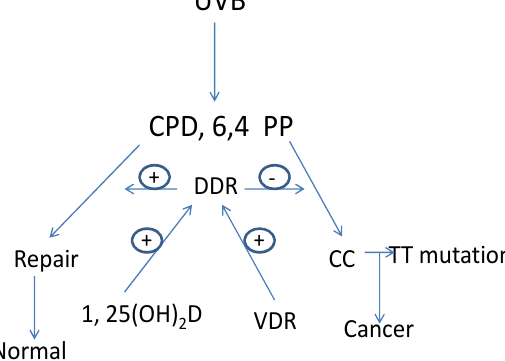
Figure 2. 1,25(OH) D/VDR regulation of DNA damage repair (DDR) in keratinocytes. 2 UVB causes DNA damage in the form of cyclobutane pyrimidine dimers (CPD) and pyrimidine(6,4)pyrimidone photoproducts (6,4PP). If these DNA lesions are not repaired mutations leading to cancer will result. This is the job of DDR, a multienzyme